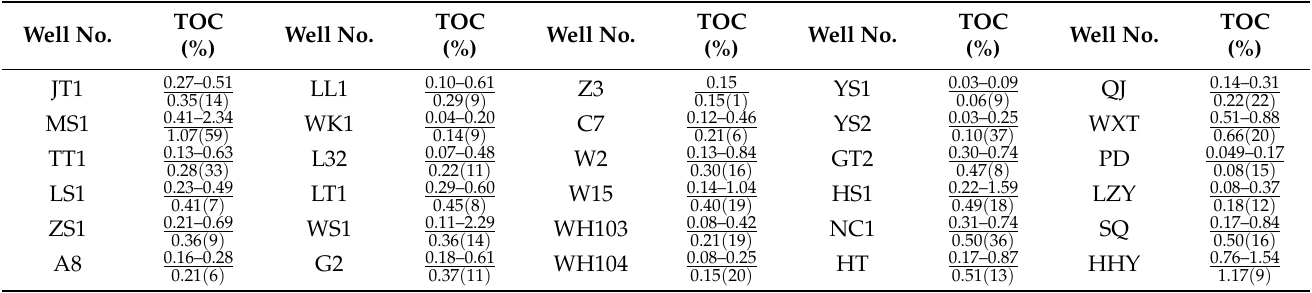
Table 5. Total organic carbon content of mudstone in the Meitan